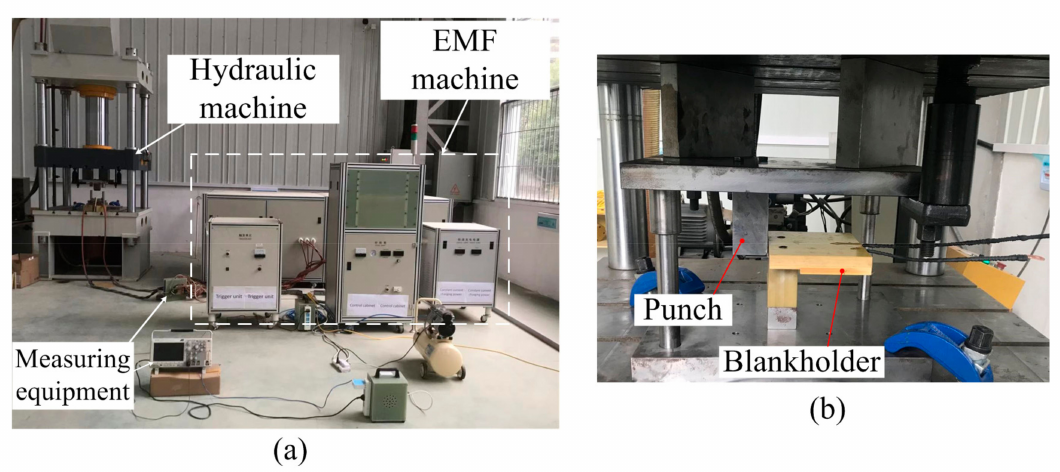
Figure 20. Experimental setup: ( a ) EMF machine and measurement equipment, ( b ) metal forming module.